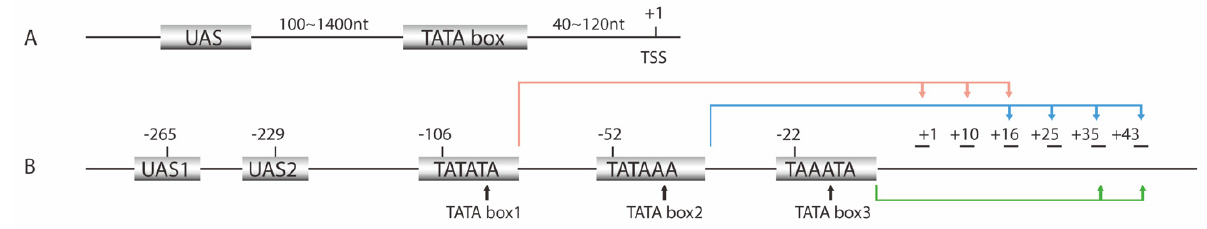
Figure 1. Promoters in S. cerevisiae . ( A ) General structure of S. cerevisiae promoters. With respect to the TATA box, UASs are located between 100 and 1400 nt upstream, whereas TSSs lie from 40 up to 120 nt downstream. ( B ) The structure of the yeast CYC1 promoter. Two UASs are present upstream of three TATA boxes, whose sequences are reported in the figure, that activate at least six TSSs [27].